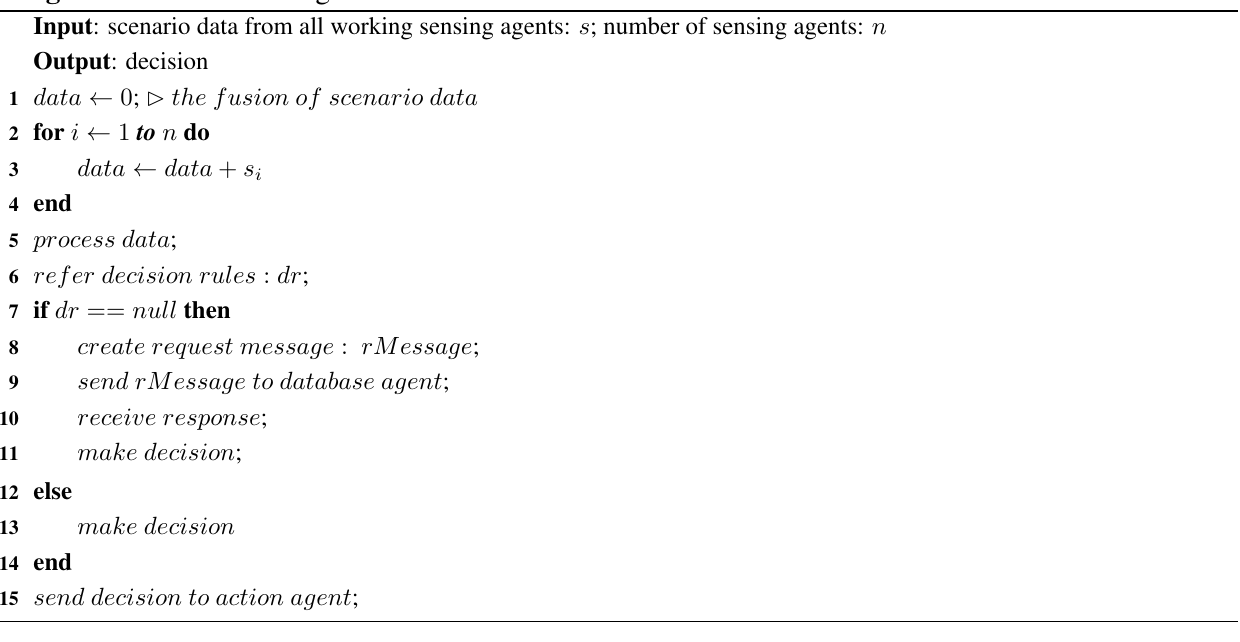
Algorithm 3 : Decision agent behavior.